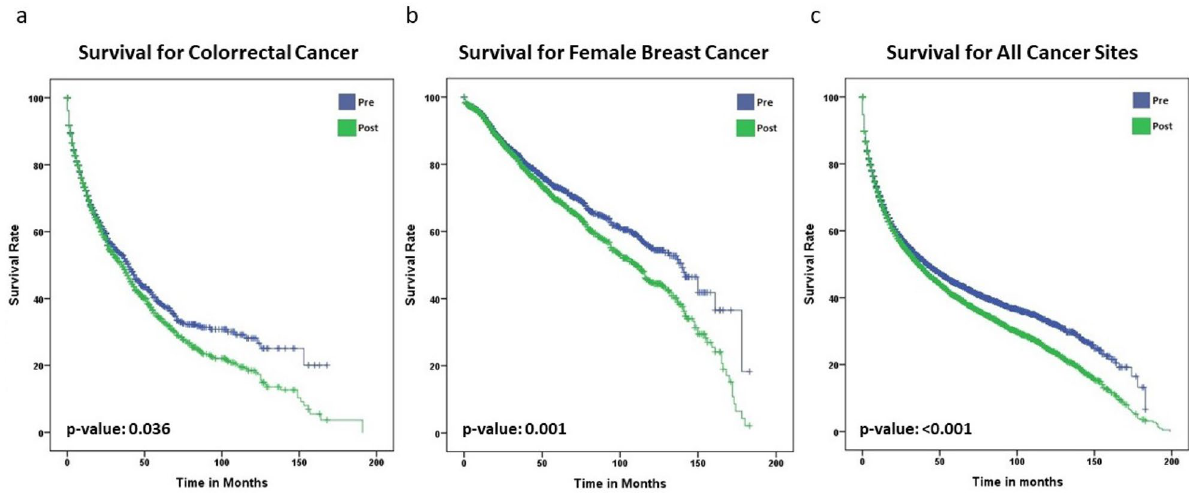
Figure 5. Comparison of the survival curves for ( a ) colorectal cancer, ( b ) female breast cancer, and ( c ) all tumour